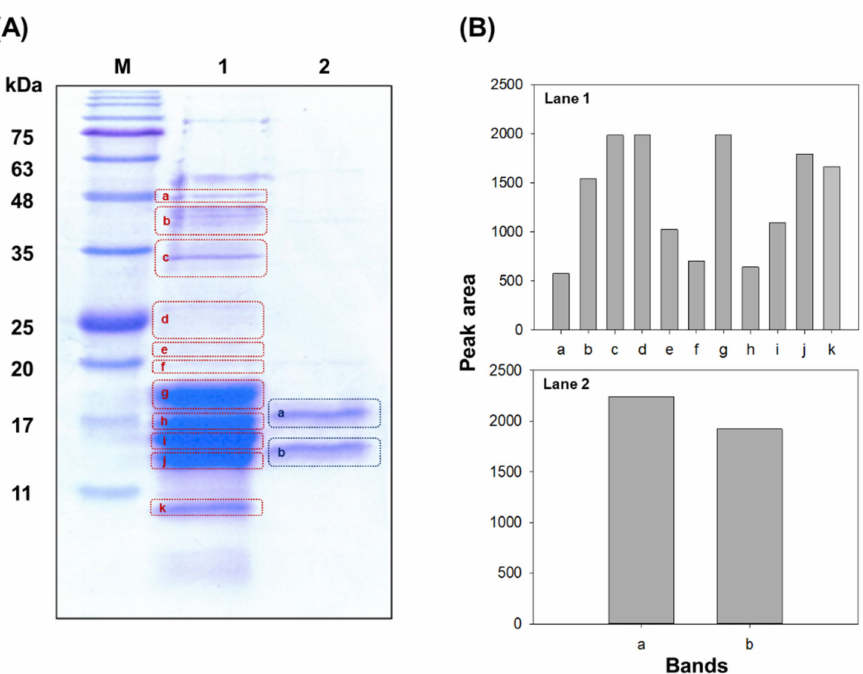
Figure 4. Purity of phycocyanin (PC) attained at crude extract and purification. SDS–PAGE of crude PC extract and purified PC from Arthrospira maxima . ( A ). Band peak areas of crude PC extract and purified PC ( B ). Lane M, protein marker (75, 63, 48, 35, 25, 20, 17, and 11 kDa); Lane 1, crude PC extract; Lane 2, purified